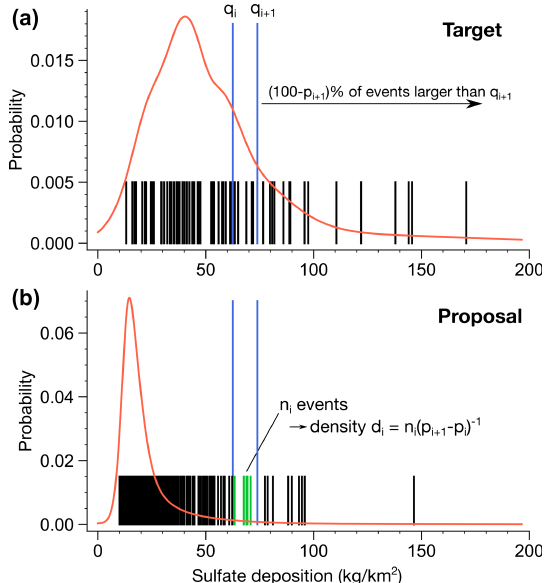
Figure B1. Illustration of the resampling method with the Antarctic sulfate deposition data set. (a) Kernel density estimate of the target distribution of the bipolar sample (red), together with the individ- ual events of the sample on the x axis (black stripes). The quan- tiles q i of the sample are calculated for a set of percentages p i . By definition, each inter-quantile interval q i - q i + 1 contains N b ( p i + 1 - p i ) / 100 bipolar events, for which N b is the size of the bipolar sam- ple. Note that for a small sample, this holds only approximately. As an example, the 70th and 80th percentiles are shown in blue. (b) The quantiles of the target sample are transferred to the proposal sample (unipolar data set), and the number of events in each inter-quantile interval is counted. Since these are the quantiles of the target sam- ple, the density of events in the intervals is no longer constant. To find the largest subset of events that follow the target distribution, the interval with lowest density d j is found, and the samples in all other intervals are thinned out to the same density. This is done by removing each event with probability 1 − d j /d i